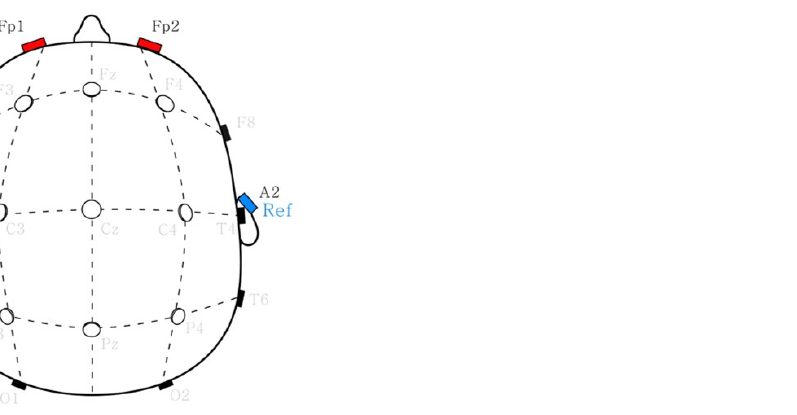
Figure 3. EEG montage of 10–20 systems [55], where Fp1 and Fp2 were used working electrodes referenced to A2 and grounded to A1.